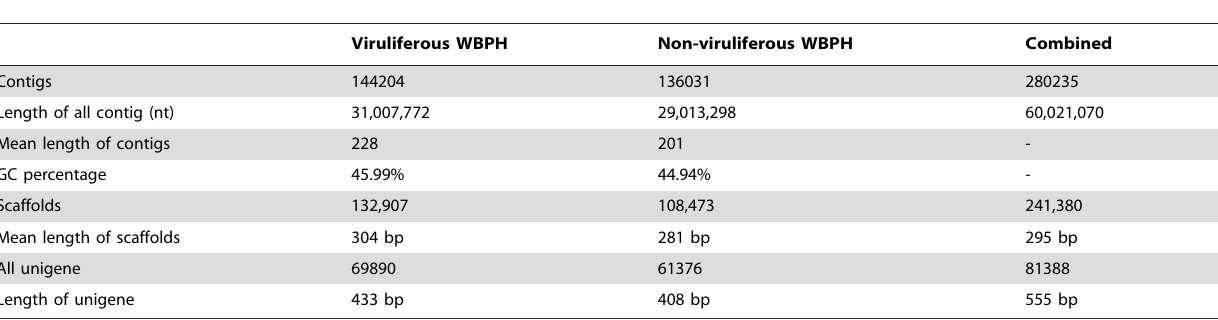
Table 1. Summary statistics for Sogatella furcifera genes resulting from Illumina deep